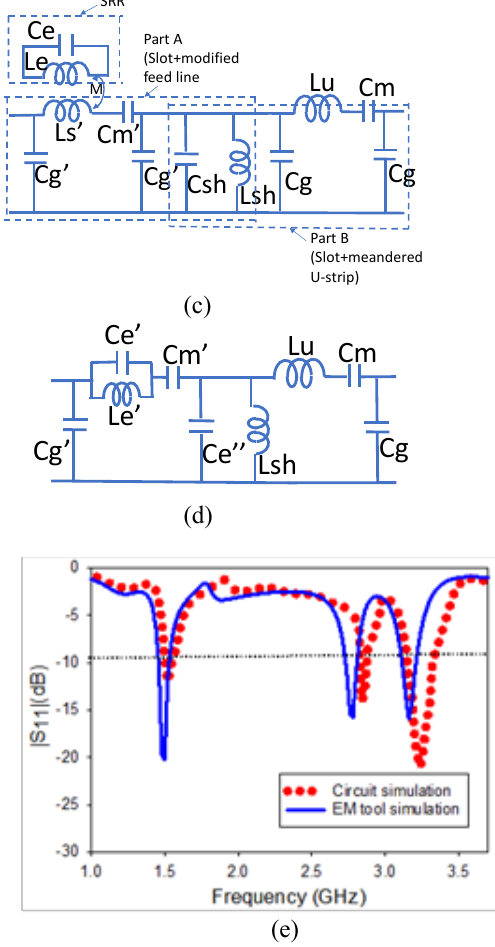
Figure 6: (a) Equivalent circuit of the unloaded slot with microstrip feed (b) Equivalent circuit model for interdigitated capacitors (c) Equivalent circuit of the proposed antenna (loaded with modified meandered feed, meandered U-strip and loaded SRR) (d) Simplified equivalent circuit for the proposed antenna (e) Reflection coefficient magnitude values for proposed antenna obtained using circuit and EM